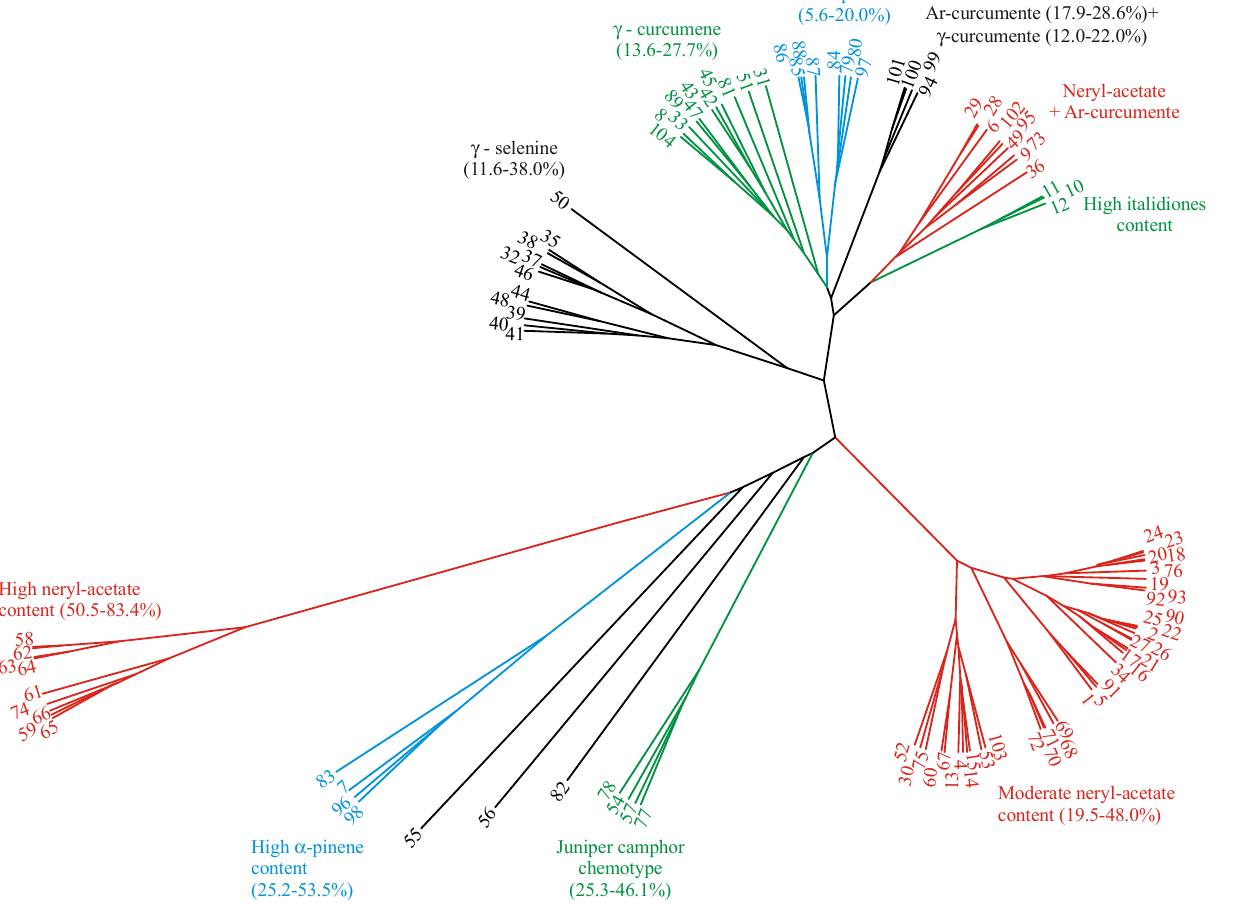
Figure 2. Unrooted phylogenetic tree of H. italicum samples based on concentration of EOs. According to data from literature about H. italicum EO chemical composition Samples with high content of neryl-acetate originate from Sardinia [16], while the ones with moderate neryl-acetate content have a wide range of distribution throughout Italy (Elba Island, Sardinia, and Tuscany) [16,18,21,42,44,57] and France (Corsica) [56,57],